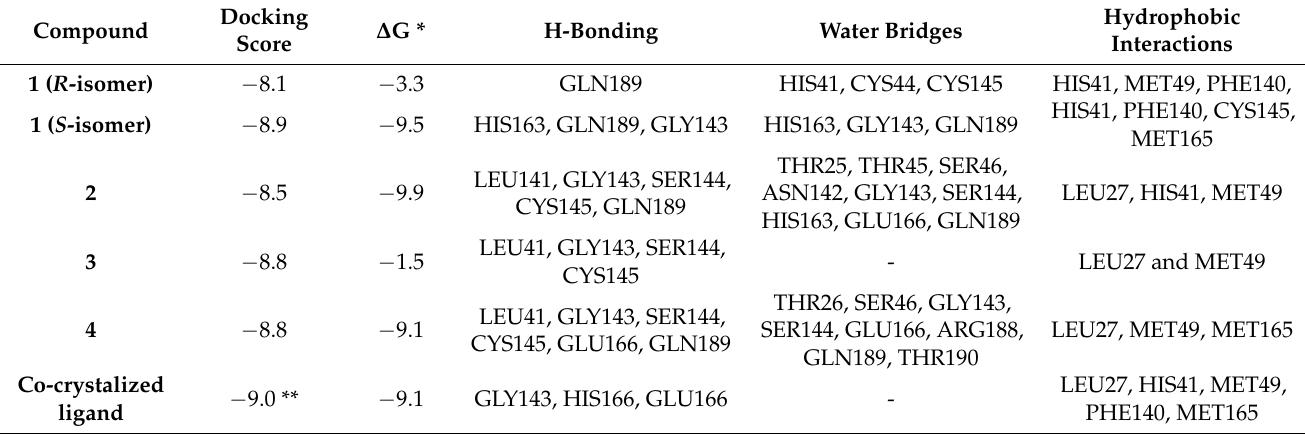
Table 1. Docking scores and ∆ Gs of compounds 1 – 4 , along with their interactions inside the M pro active site. Compound Water Bridges